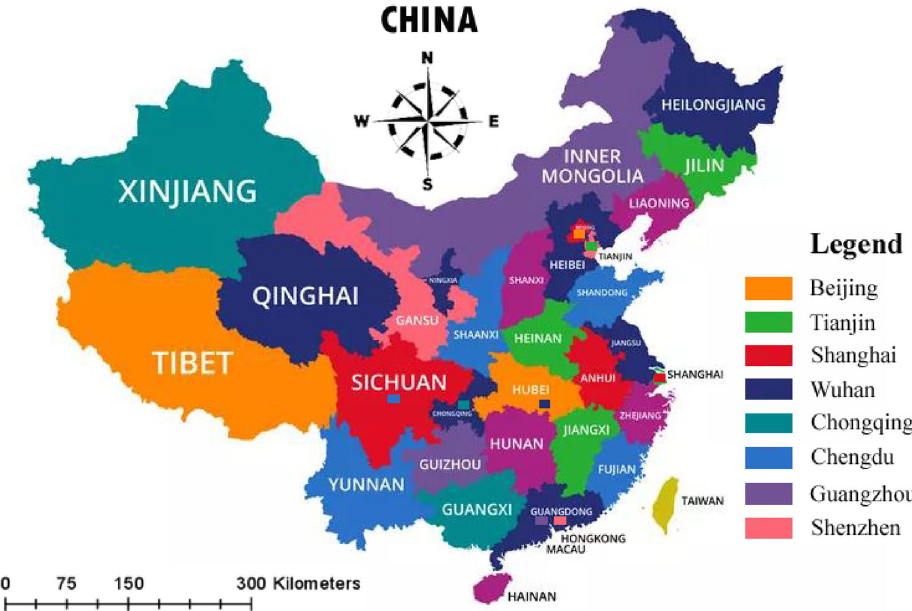
Figure 2. Study area: Authors have downloaded a free version of the Chinese map available at https:// graph. baidu. com/ and used Adobe PhotoShop CS5 to incorporate legend. The legend shows the name of Chinese cities where the survey was conducted to collect the dataset for analysis.